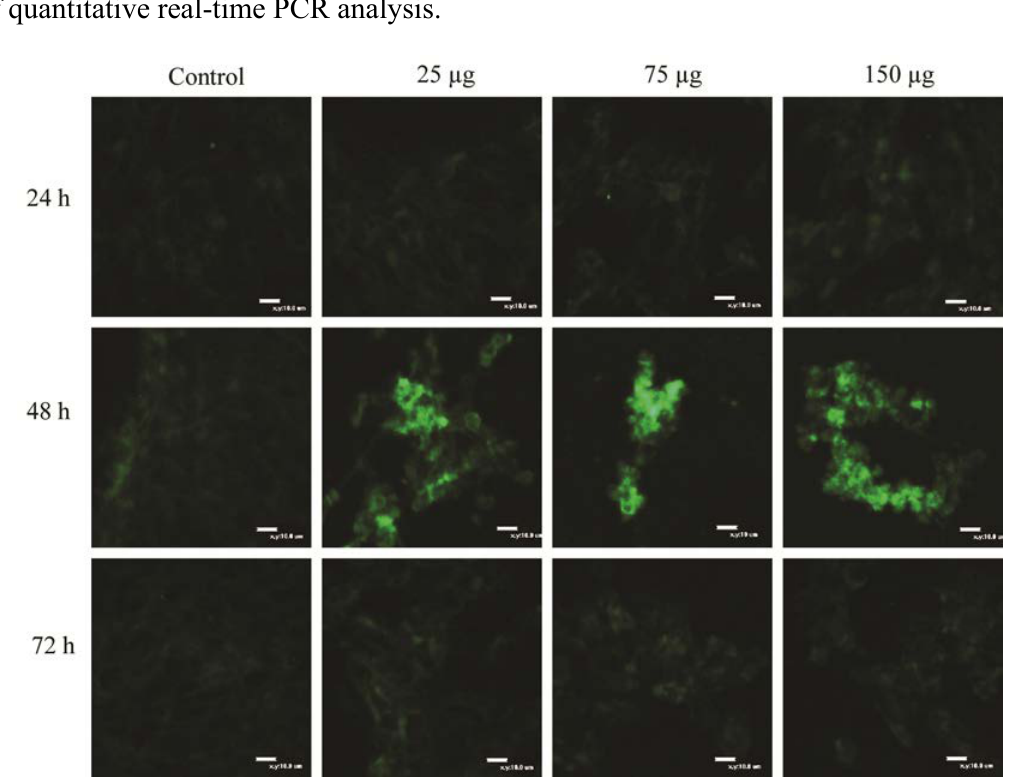
Figure 4. Confocal microscopic images of the expression of GST genes in HepG2 treated with MgO nanoparticles. Molecular beacons targeting the GST gene were delivered into live cells by a reverse permeabilization method using an activated SLO. The fluorescent live cell images at 24 h ( top panel), 48 h ( middle panel) and 72 h ( bottom panel) were presented with excitation at 488 nm and emission detection at 530 nm. The intensity of the fluorescent signals was maximized at 48 h incubation time in proportion to MgO concentrations (scale bar size: 10 µm). The intensity of the fluorescent signals was found to be weak due to the low expression of target